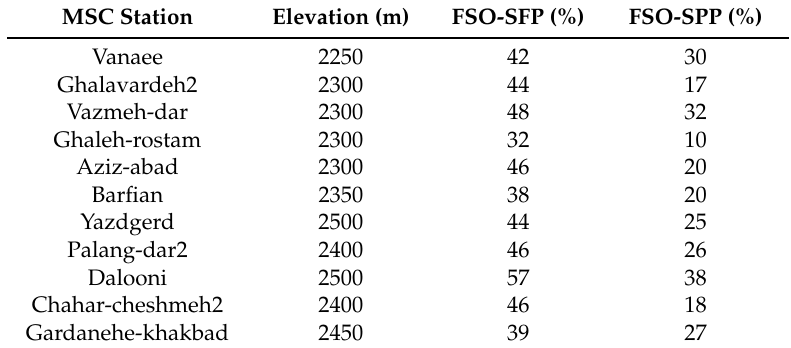
Table 2. Existing manual snow-course (MSC) stations in altitudinal range of 2250–2500 m in Dez Basin.